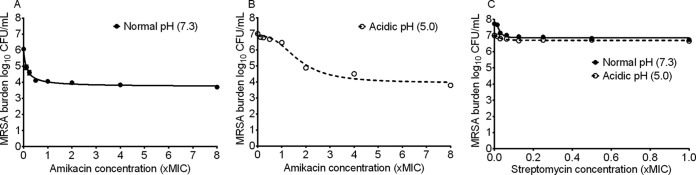
Effect of pH on aminoglycoside efficacy against MRSA. (A) Amikacin had a good Emax against MRSA at normal pH. (B) The amikacin Emax was higher at pH 5.0. In other words, amikacin efficacy was not dependent upon the pH of the growth medium. (C) However, the streptomycin Emax and EC50 were altered by the pH changes.